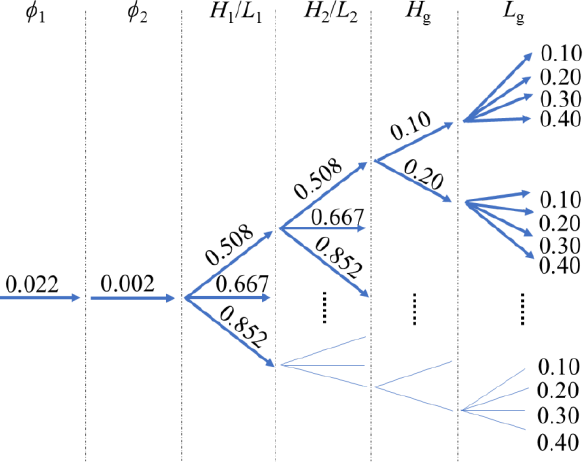
Figure 6. Illustration of the Constructal Design applied to the OTD-WEC with two ramps.